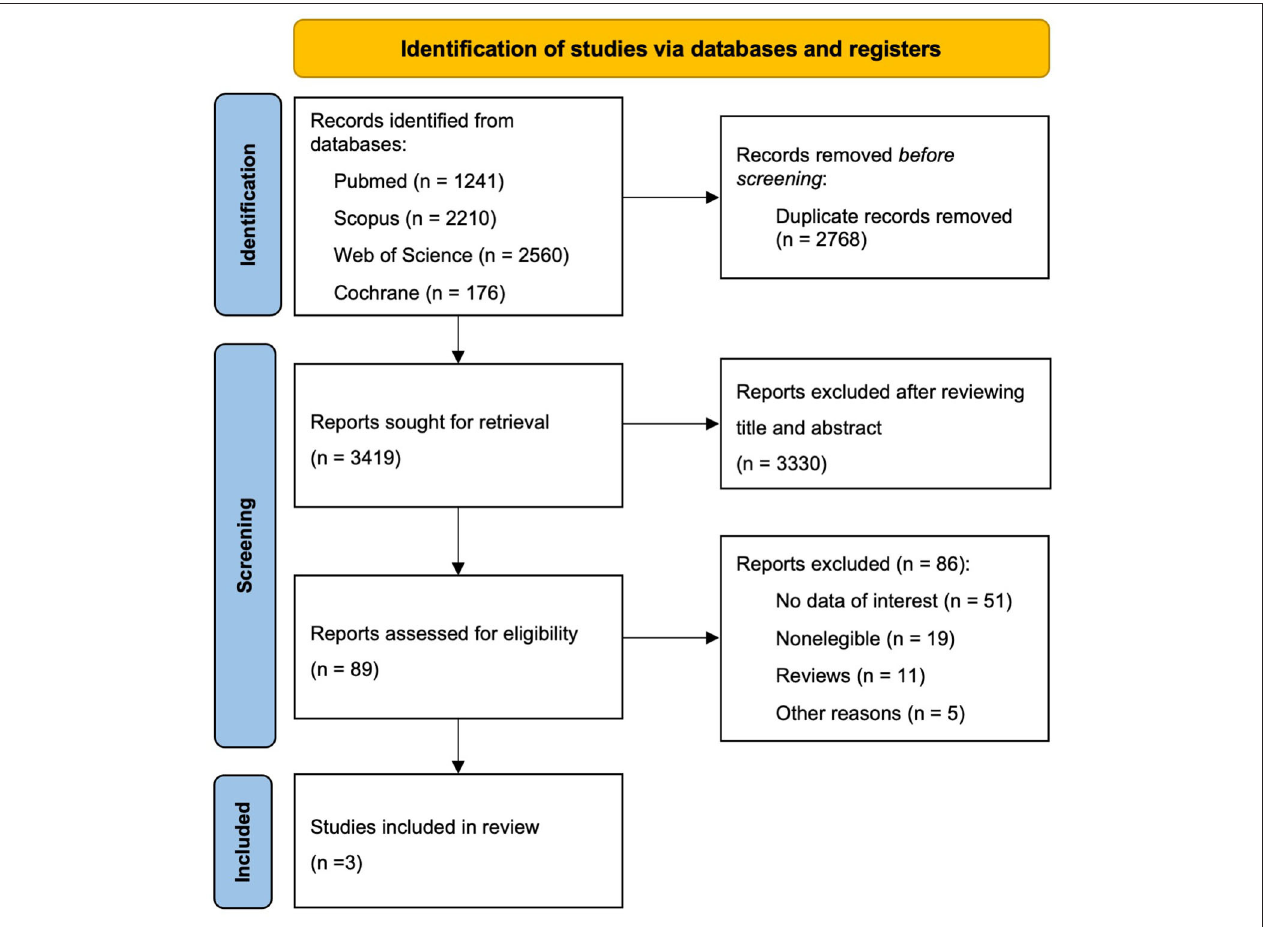
FIGURE 1 | PRISMA 2020 flow diagram of study